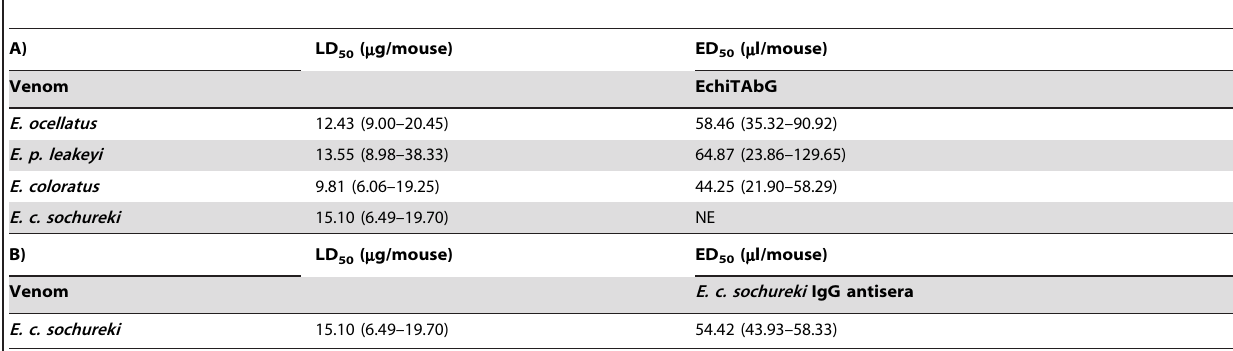
Table 3. Venom lethality and venom-neutralising efficacy of (A) EchiTAbG and (B) the E.c. sochureki IgG antisera.